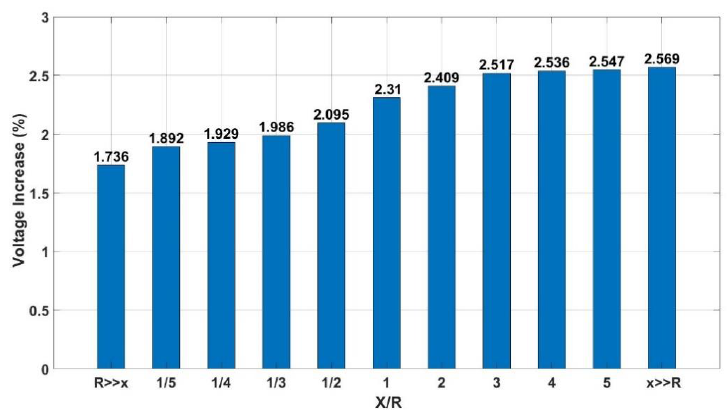
Figure 12. Voltage increase (%) for different X/R ratios when both active and reactive power was used for voltage regulation.